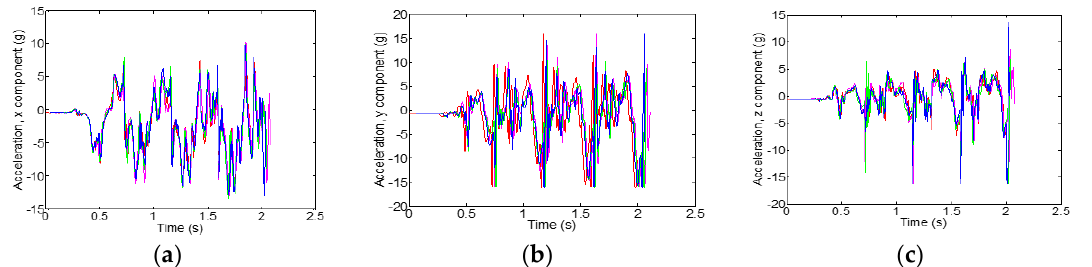
Figure 2. Right shank acceleration for the first seven foot strikes for all five trials from participant two. ( a ) x component, shank aligned ( b ) y component, anterior-posterior axis ( c ) z component, medio- lateral axis. Note that the acceleration profiles are limited to the +16 g